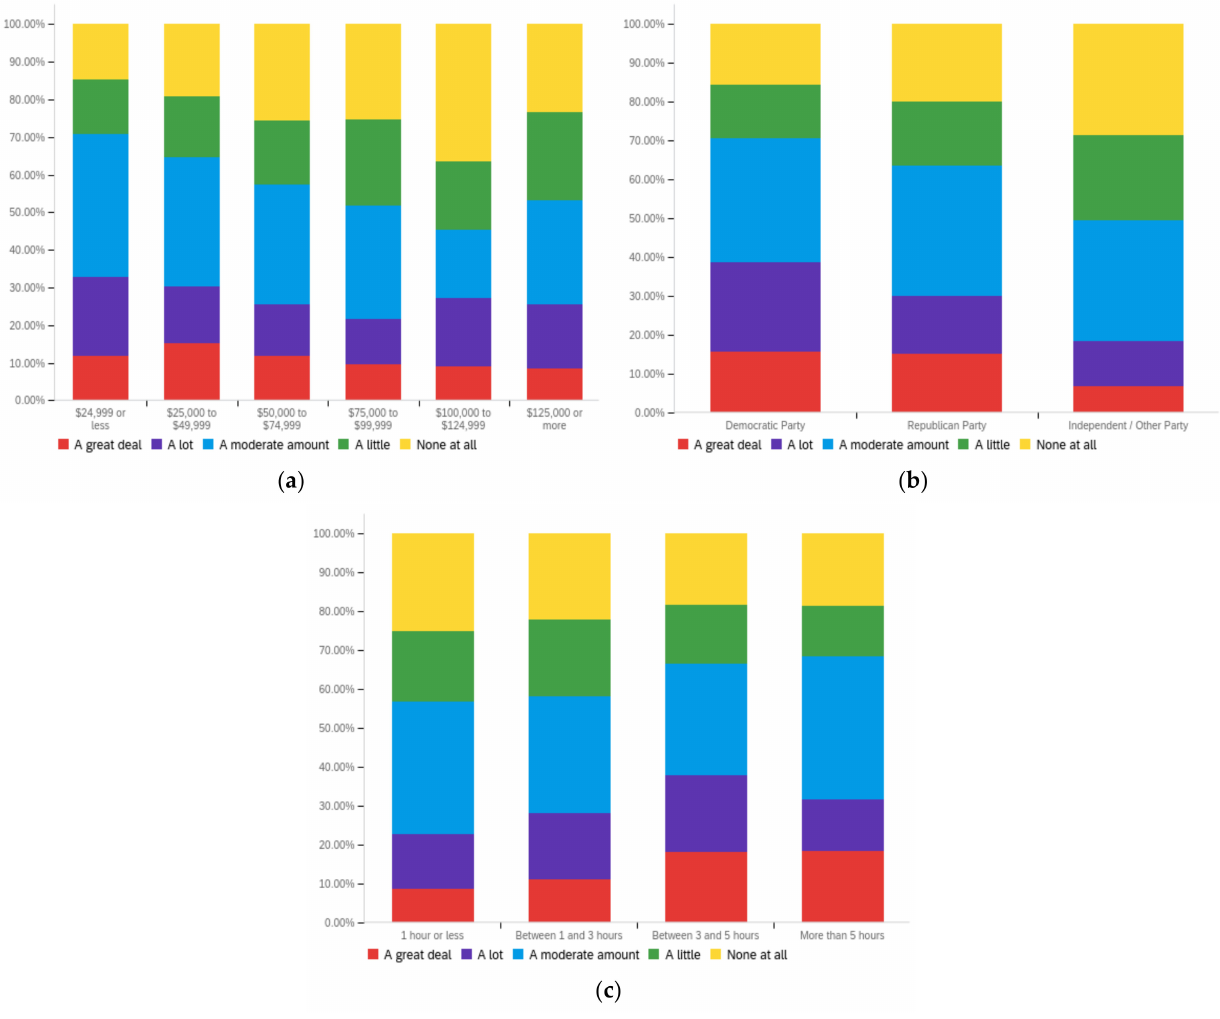
Figure A30. Article virality—ideal perception impact by: ( a ) income level (top left), ( b ) political affiliation (top right) and ( c ) online usage